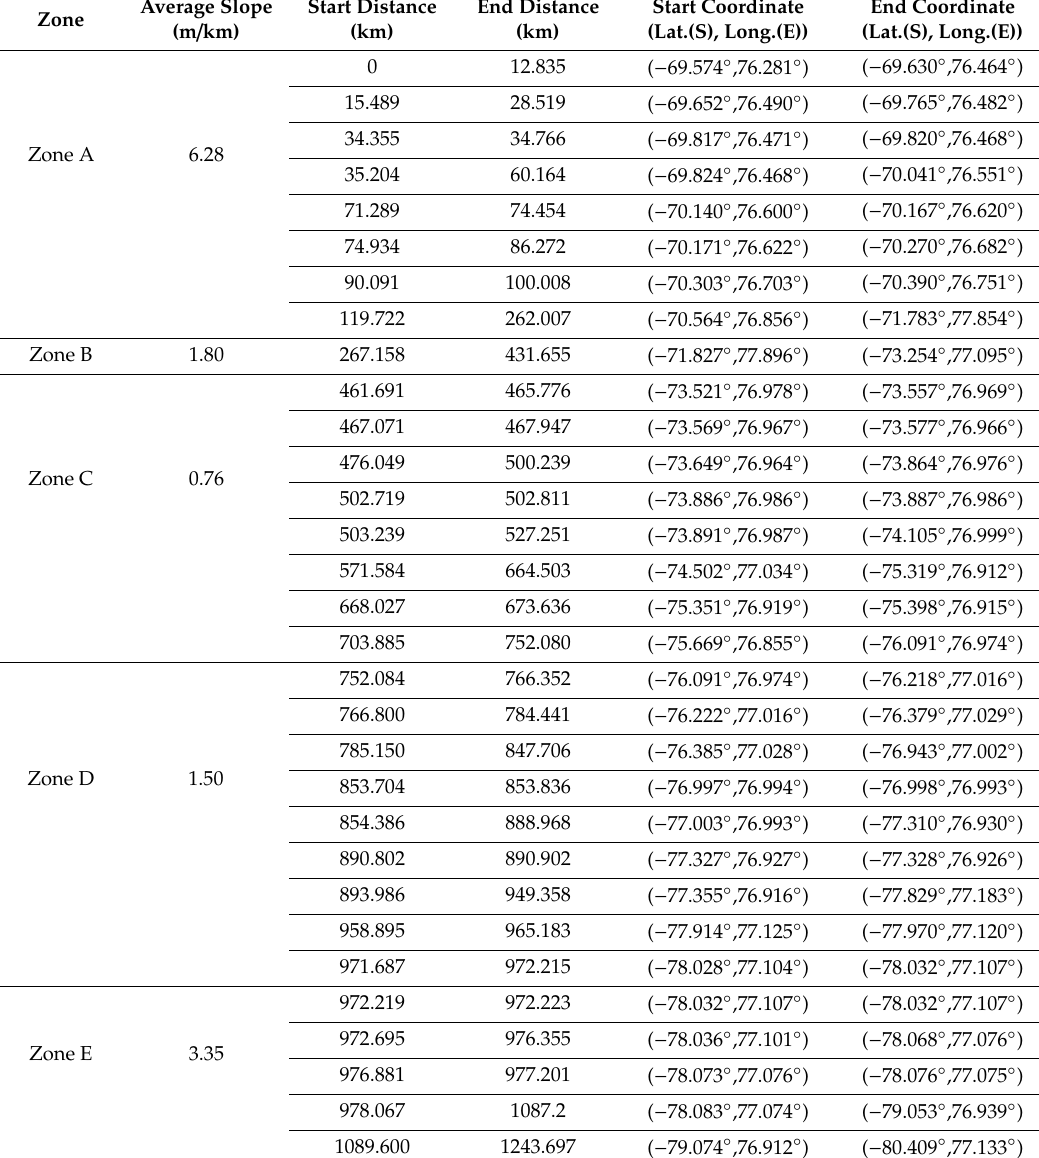
Table 2. Location of each IPR line along the transect from Zhongshan to Dome A, East Antarctica. The abbreviations of Lat. and Long. are latitude and longitude,